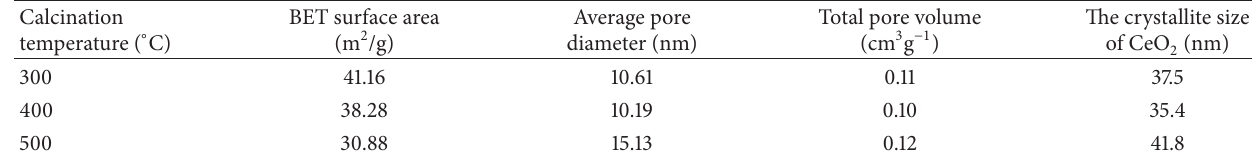
O /CeO catalysts with 5 wt.% Co 3 4 2